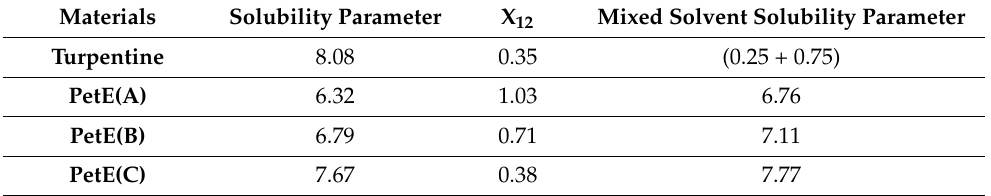
Table 2. Solubility and Flory-Huggins interaction parameters for pure and mixed solvents [17].